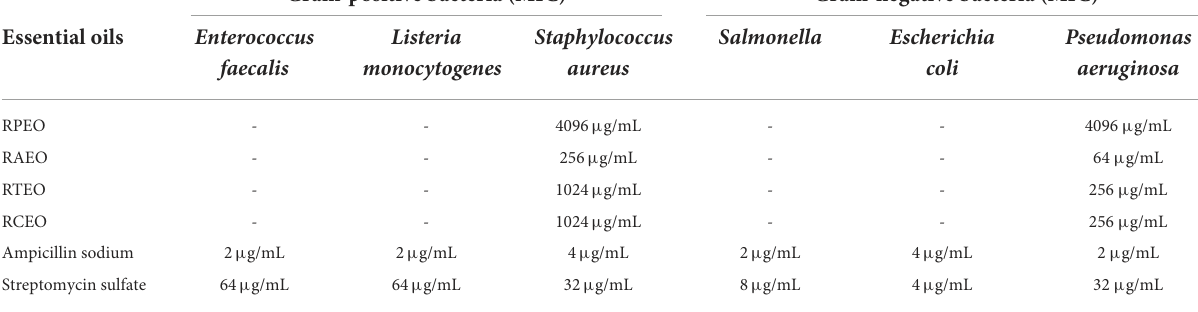
TABLE 2 The antibacterial activity of the essential oils from four Rhododendron species.